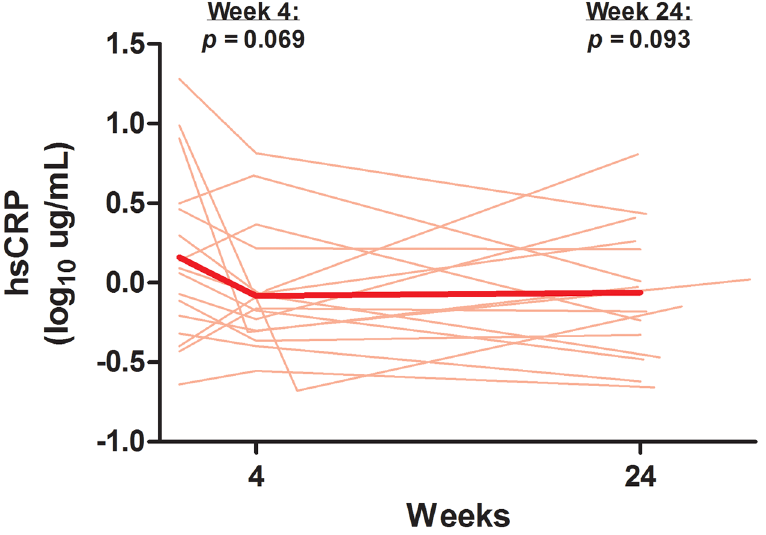
Figure 7. Change in high sensitivity C-reactive protein. Thin lines indicate data for each individual subject. The thick line indicates the estimated mean value over time from mixed effects linear regression. P-values refer to change from baseline at each referenced time-point. hsCRP=high sensitivity C-reactive protein.